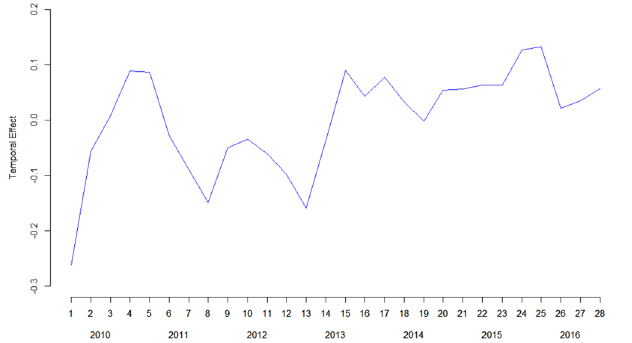
Figure 2. Temporal effect during the period